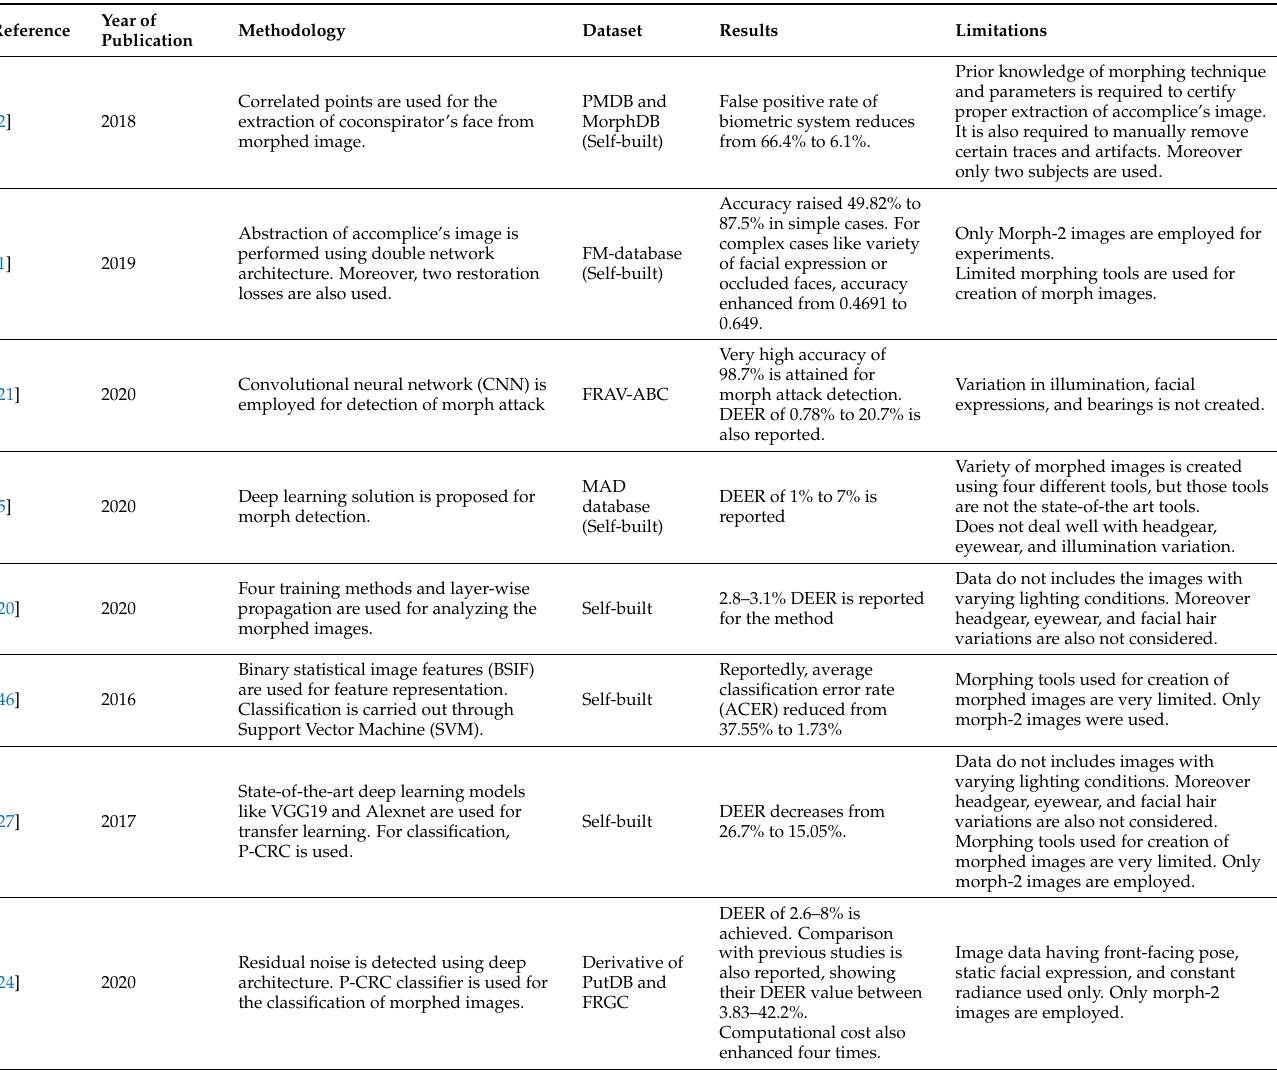
Table 2. Comparison of research work on morph attack